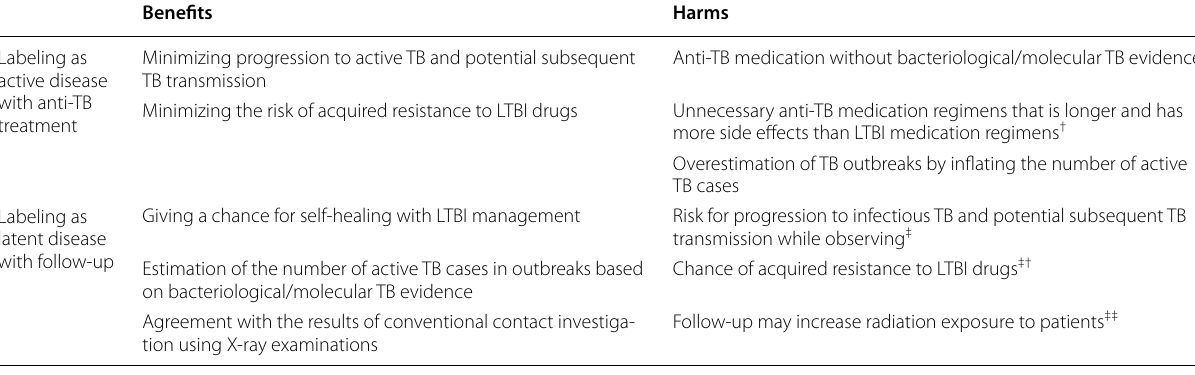
CT —computed tomography; PET— positron emission tomography; TB —tuberculosis; LTBI —latent tuberculosis infection †